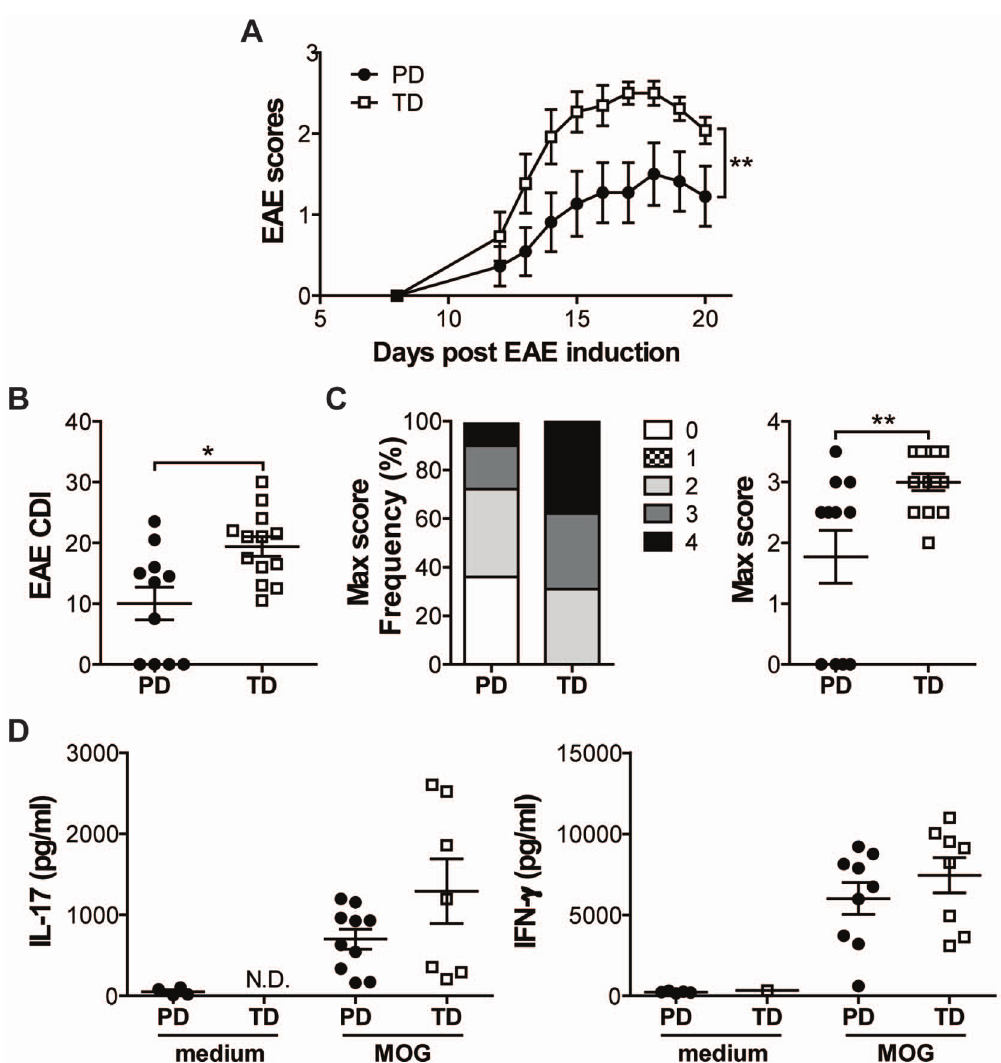
Figure 6. Diet-mediated effects on development of EAE in WT mice. (A) Daily mean EAE scores of WT mice fed PD or TD (n=11–13 mice/ group). TD was significantly different from PD (**P , 0.01, two-way ANOVA). (B) CDI of PD- or TD-fed mice. (C) The frequency of mice with individual EAE scores and the maximum EAE severity for each mouse. TD was significantly different from PD in CDI and maximum EAE scores (n=11–13 mice/ group, *P , 0.05, **P , 0.01, unpaired t test). (D) IFN- c and IL-17 production (n=4–10 mice/group). Values are the mean 6 SEM from two independent experiments. CDI, Cumulative disease index; EAE, experimental autoimmune encephalomyelitis; ND, not detectable; PD, purified diet; TD, Teklad diet; WT,